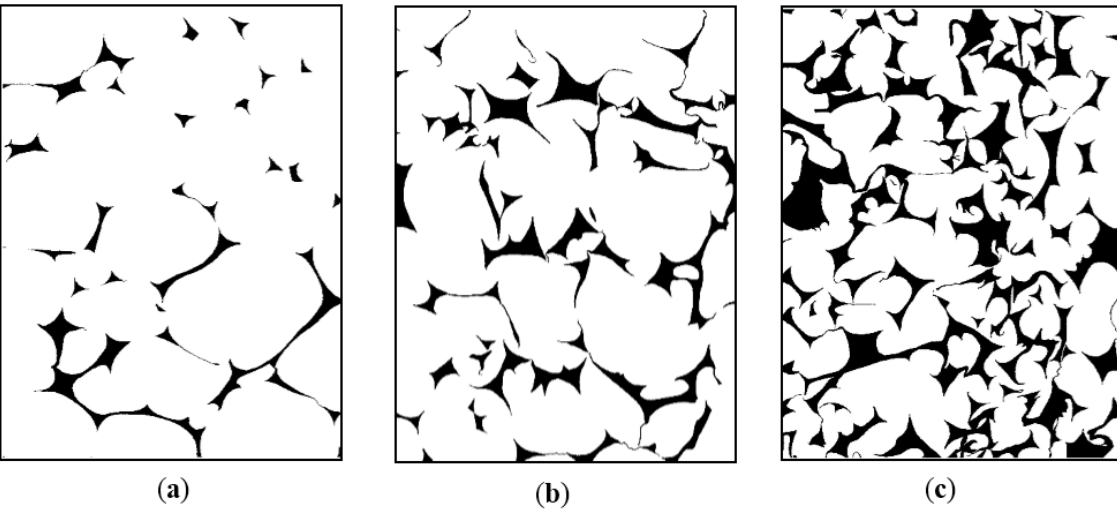
Figure 7. Comparison of contact areas of the conductive foam. Black areas indicate the surface of the conductive foam: ( a ) no compression (0.0 kPa); ( b ) compressed at 2.0 kPa; ( c ) compressed at 3.0